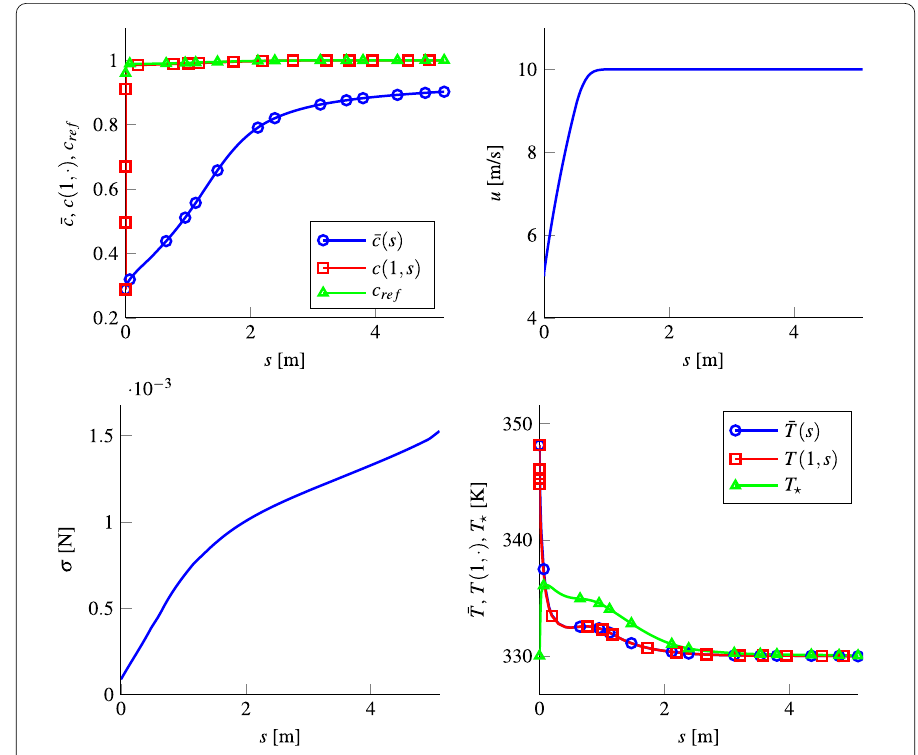
Figure 2 Solution quantities of a centrally located fiber (cf. Fig. 1). Top-left: Polymer (CA) mass fraction (averaged ¯ c , at the fiber boundary c | r =1 and referential c ref ). Top-right: Scalar fiber speed u . Bottom-left: Tensile stress σ . Bottom-right: Temperature (averaged ¯ T , at the fiber boundary T | r =1 , air T (cid:5) )